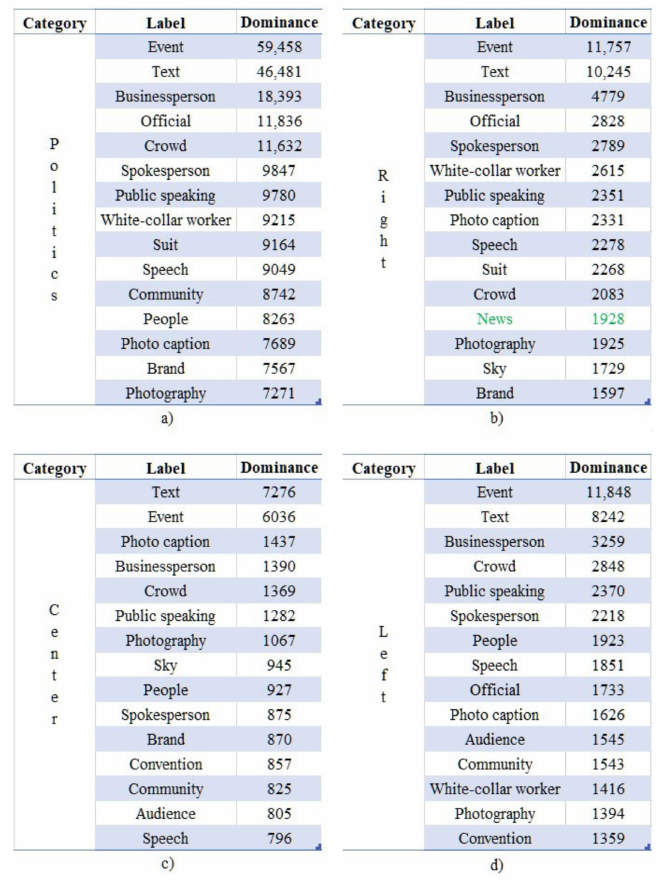
Figure 5. The top 15 dominant labels ( a – d ) per community of